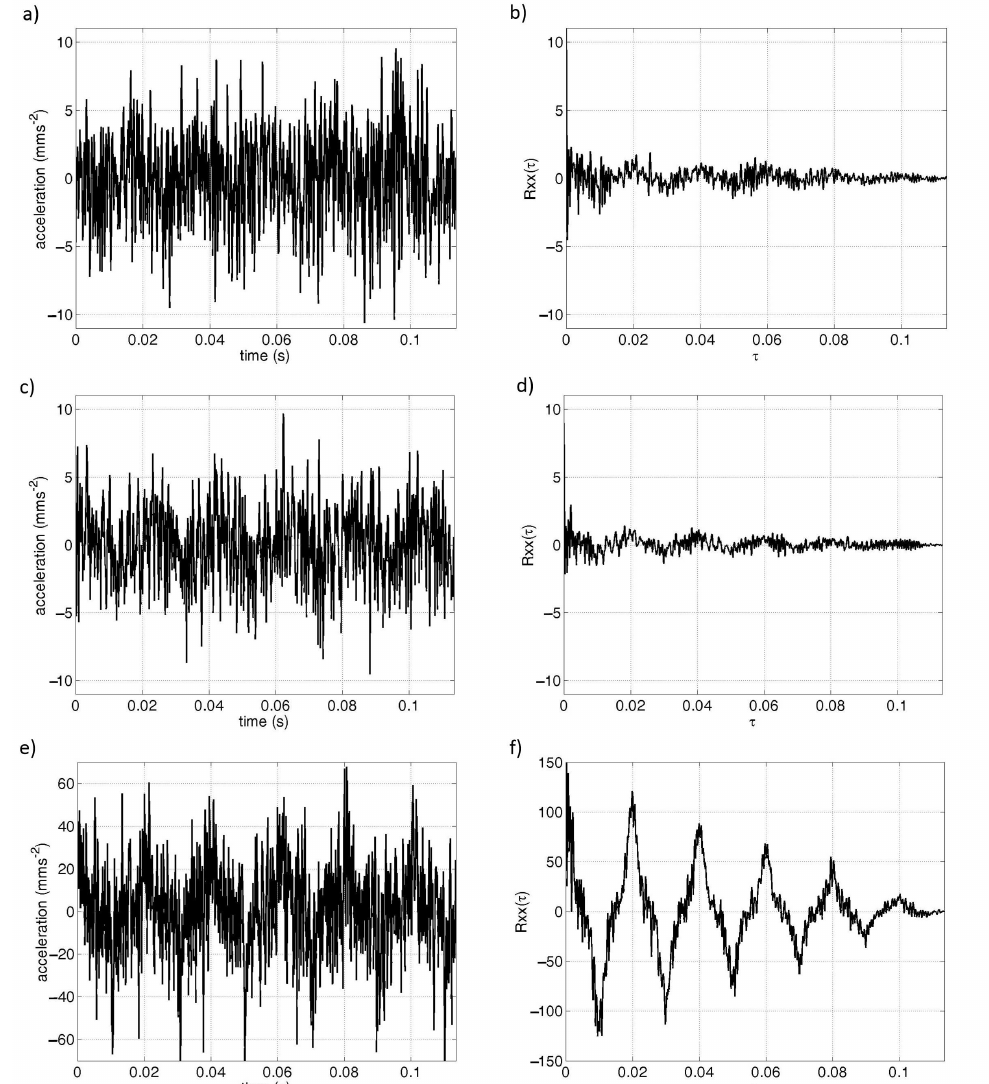
Figure 7. Time waveforms of the measured signals during the operation of the pair of aggregates in the operating modes VII.–IX. (( a ) time waveform of the signal of three aggregates without a drill bit, ( b ) auto-correlation function of three aggregates without a drill bit, ( c ) time waveform of the signal of three aggregates with a drill bit, ( d ) auto-correlation function of three aggregates with a drill bit, ( e ) time waveform of the andesite rock disintegrating signal, ( f ) auto-correlation function of the andesite rock disintegrating